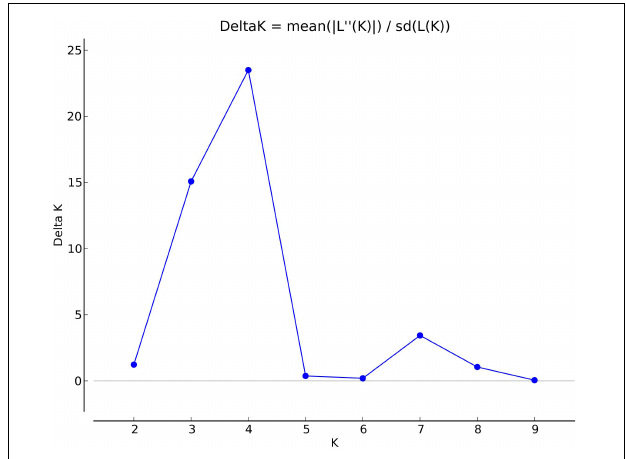
FIGURE 11 | Delta K values for different numbers of populations assumed (K) in the STRUCTURE